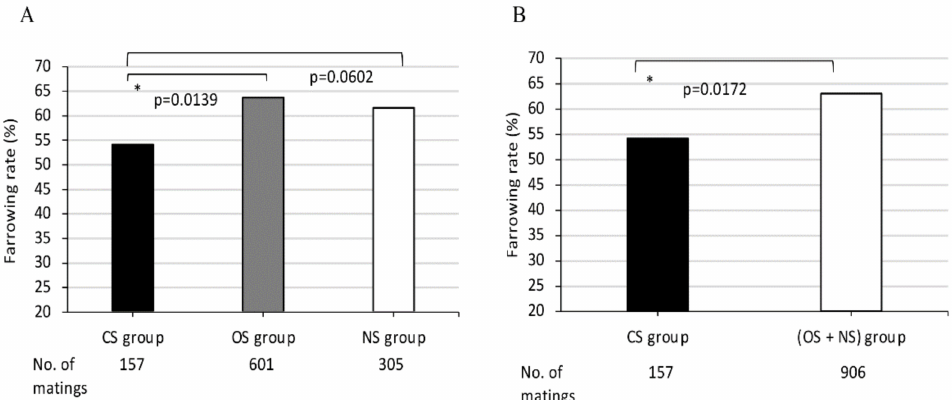
Figure 3. Comparison of farrowing rates in MMPs among ( A ) three groups CS, OS, NS, and ( B ) be- tween two groups CS and (OS + NS). CS, completely sharing SLA class II- DQB1 alleles between partners; OS, sharing only one DQB1 allele between partners; NS, non-sharing, that is, completely different DQB1 alleles between partners. X-axis shows CS, OS, and NS groups ( A ) and CS and (OS + NS) groups ( B ) and the number of matings for each group. Y-axis shows farrowing rate as indicated by the ratio (%) of the number of deliveries to the number of matings, expressed as the mean value (bar). Black and white bars represent lower and higher farrowing rate, respectively, of the mean values. Gray bars represent intermediate farrowing rate of the mean values between those of black and white bars. Probabilities of significant differences among groups are indicated by single ( p < 0.05)